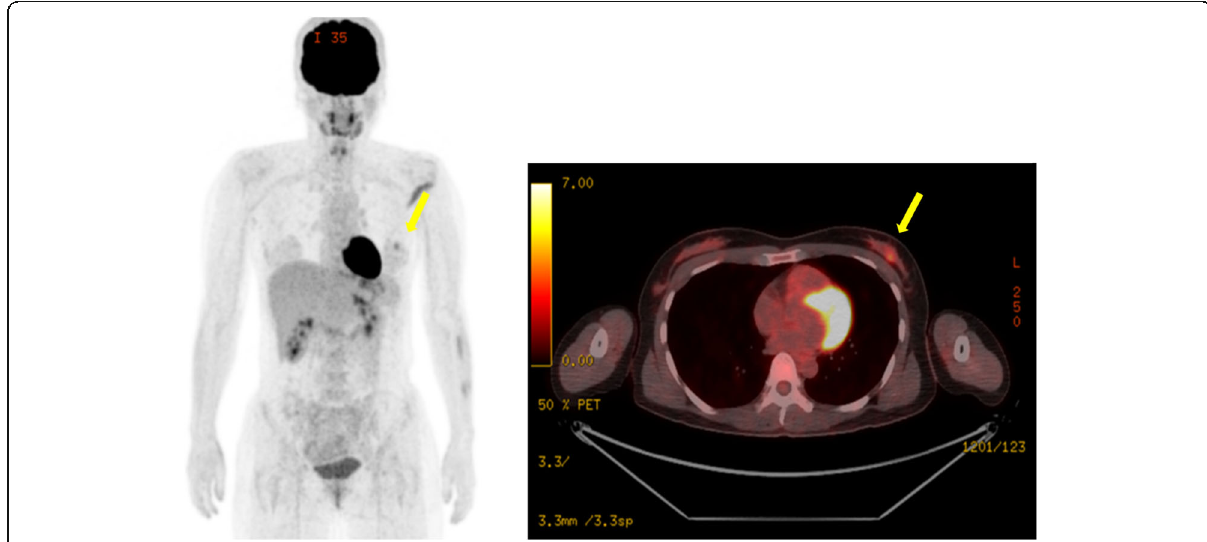
Fig. 4 Whole-body fluorodeoxyglucose (FDG) positron emission tomography-computed tomography (PET-CT). Whole-body FDG PET-CT images showing a mass in the left C area with a maximum standardized uptake value of 3.54 (yellow arrows). Other abnormal accumulations were not detected in other axillary lymph nodes, lungs, liver, and